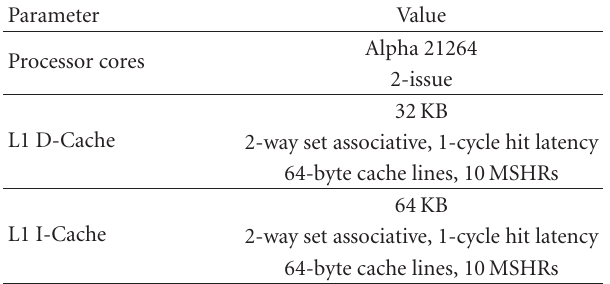
Table 2: Core Parameters.